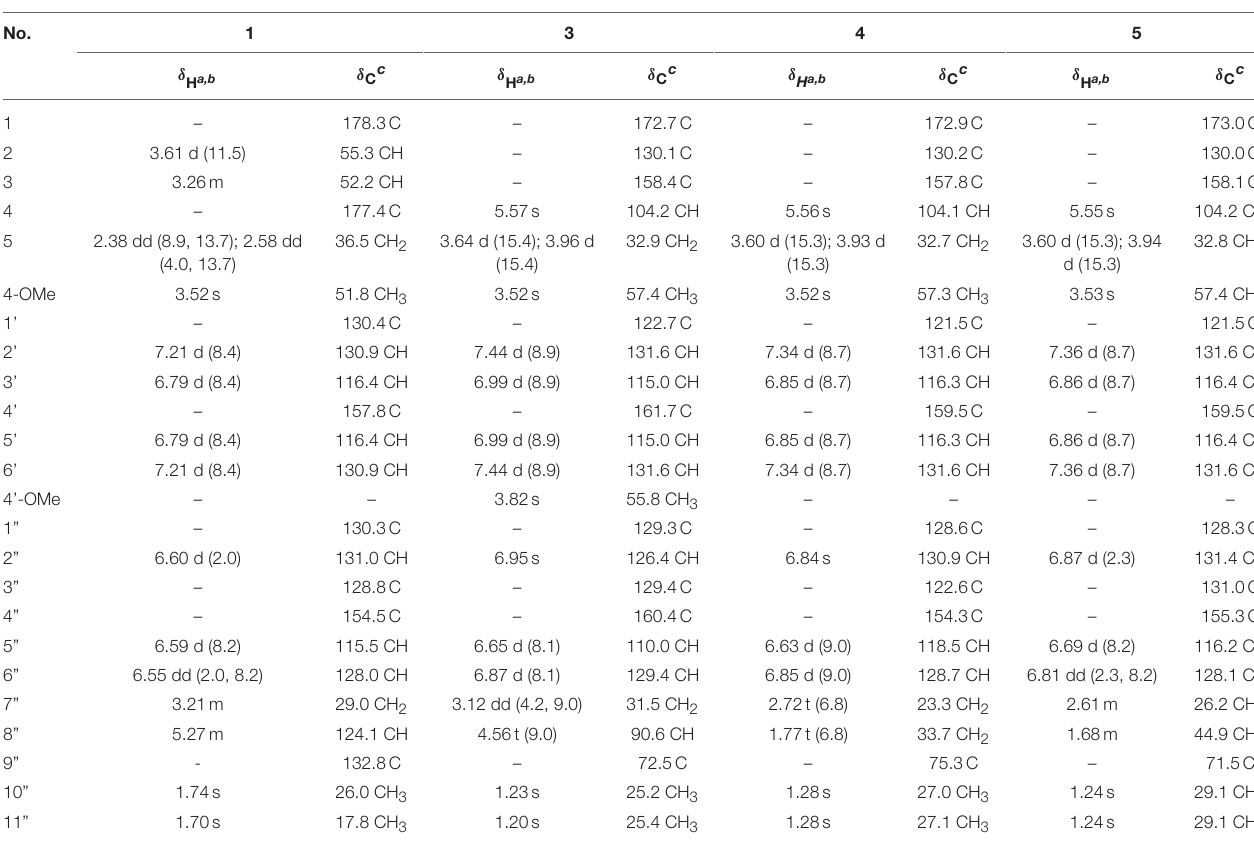
TABLE 1 | 1 H and 13 C NMR data for compounds 1 and 3–5 in methanol- d 4 ( δ in ppm and J in Hz).